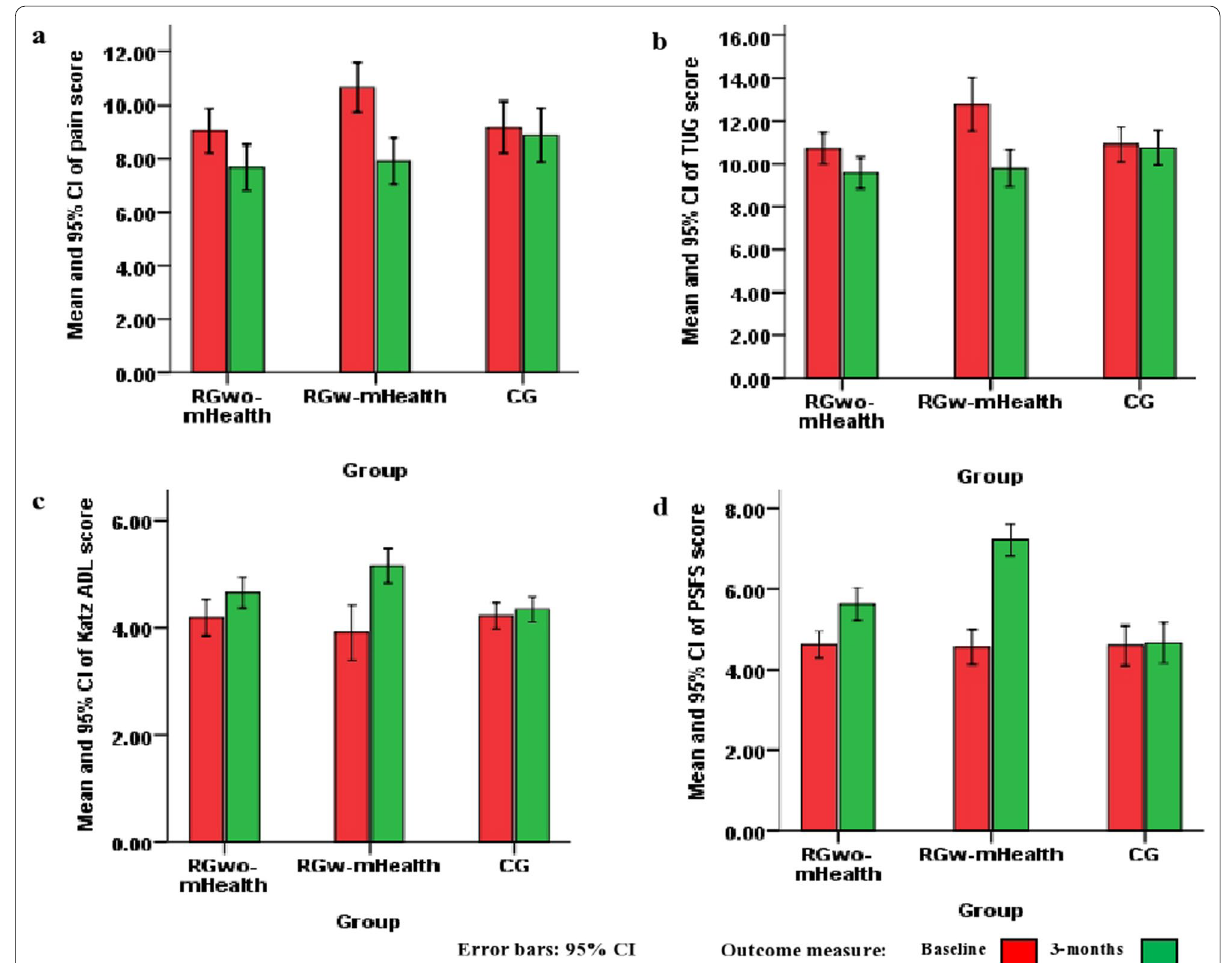
Fig. 2 Mean and 95% CI of the outcomes measures across the three groups. a mean and 95% CI of WOMAC pain score at baseline and 3-month follow-up, b mean and 95% CI of TUG test score at baseline and 3-month follow-up, c mean and 95% CI of Katz ADL score at baseline and 3-month follow-up, d mean and 95% CI of PSFS score at baseline and 3-month follow-up. WOMAC Western Ontario and McMaster Universities = Osteoarthritis Index; TUG Timed Up and Go; ADL Activities of daily living; PSFS Patient specific functional scale; CI Confidence = = = =